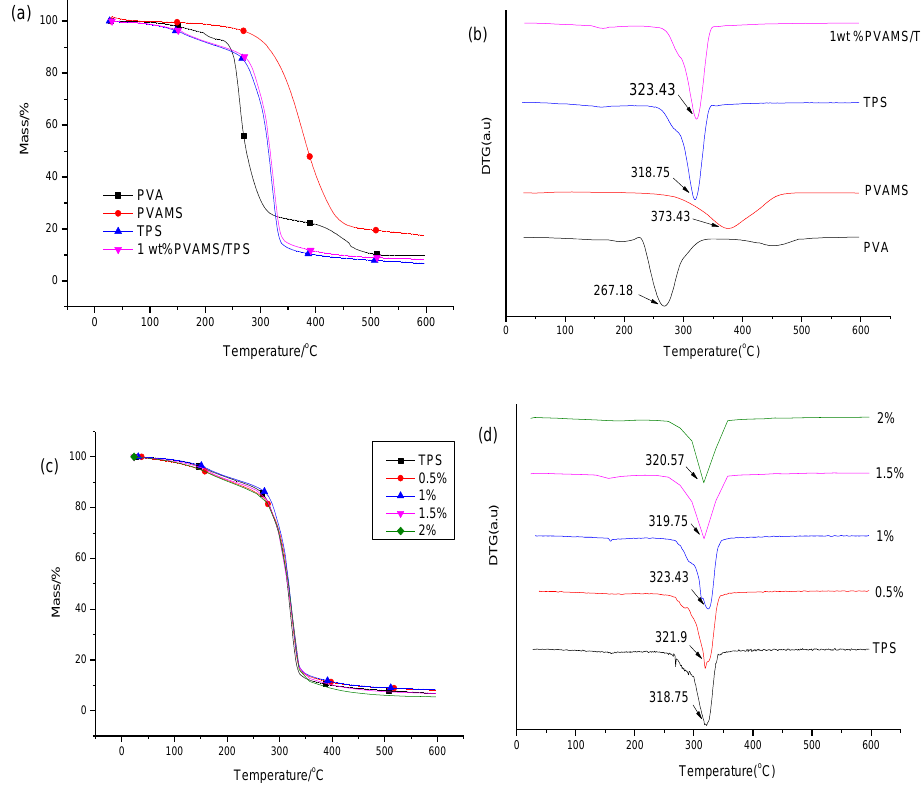
Figure 4. TG(thermogravimetry) ( a ) and DTG(differential thermogravimetry) ( b ) curves forpolyvinyl alcohol(PVA), PVAMS, TPS and 1 wt % PVAMS /TPS composites; TG ( c ) and DTG ( d ) curves of PVAMS/TPS composites prepared with varying PVAMS content (0–2 wt %).